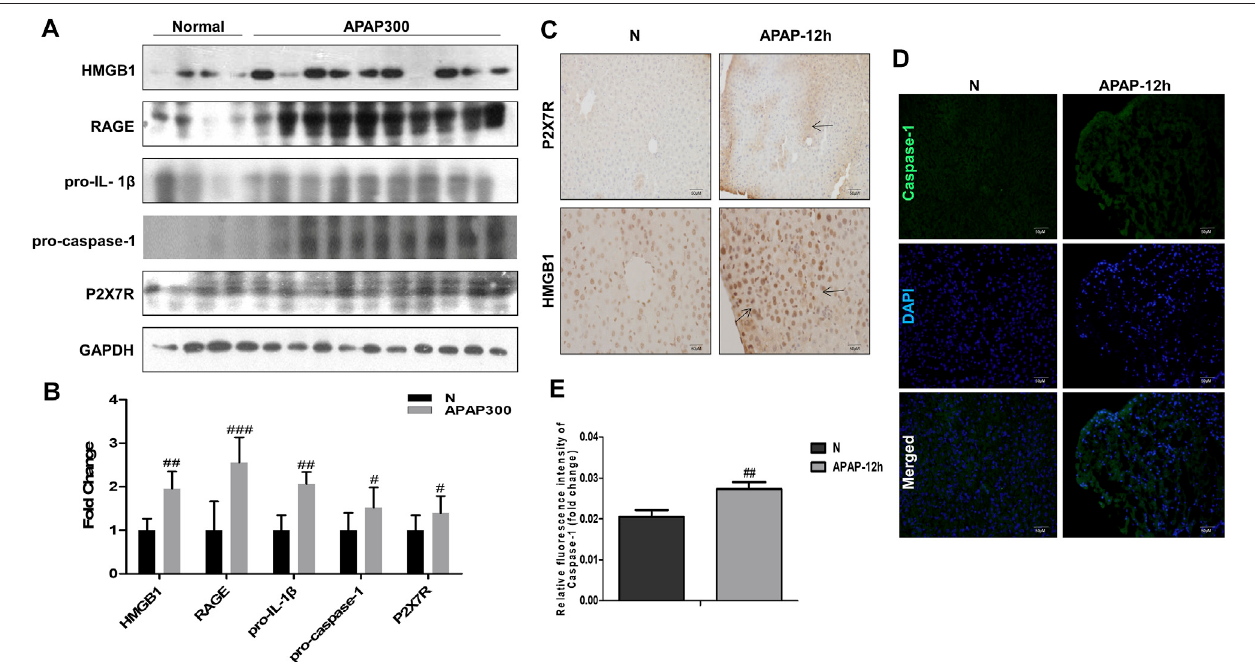
FIGURE 6 | The in fl ammatory mechanism of liver injury in APAP fasting model was observed at 12 h in the damage phase. (A,B) Normal group and fasting group, 12 hafterAPAP(300 mg/kg)treatment,westernblotresultsofHMGB1,itsreceptorproteinsRAGE,IL-1 β ,Caspase-1andP2X7Randitsquantitativeanalysisrelativeto GAPDH. (C) HMGB1andP2X7Rimmunohistochemicalstaining,imagemagni fi cation200 × ,ofwhichHMGB1magni fi cation400 × .Thepositionindicatedbythearrowis thecharacteristicstain. (D,E) FLICAstainingandrelative fl uorescencequantitativeanalysisofCaspase-1,theimageismagni fi ed200 × . # p < 0.05, ## p < 0.01, ### p < 0.001,signi fi cantlydifferentfrom normalgroup. One-wayANOVA followed byTukey ’ stest. Thedataareexpressed asthemean ± SDof fi veindependentassayswithat least three